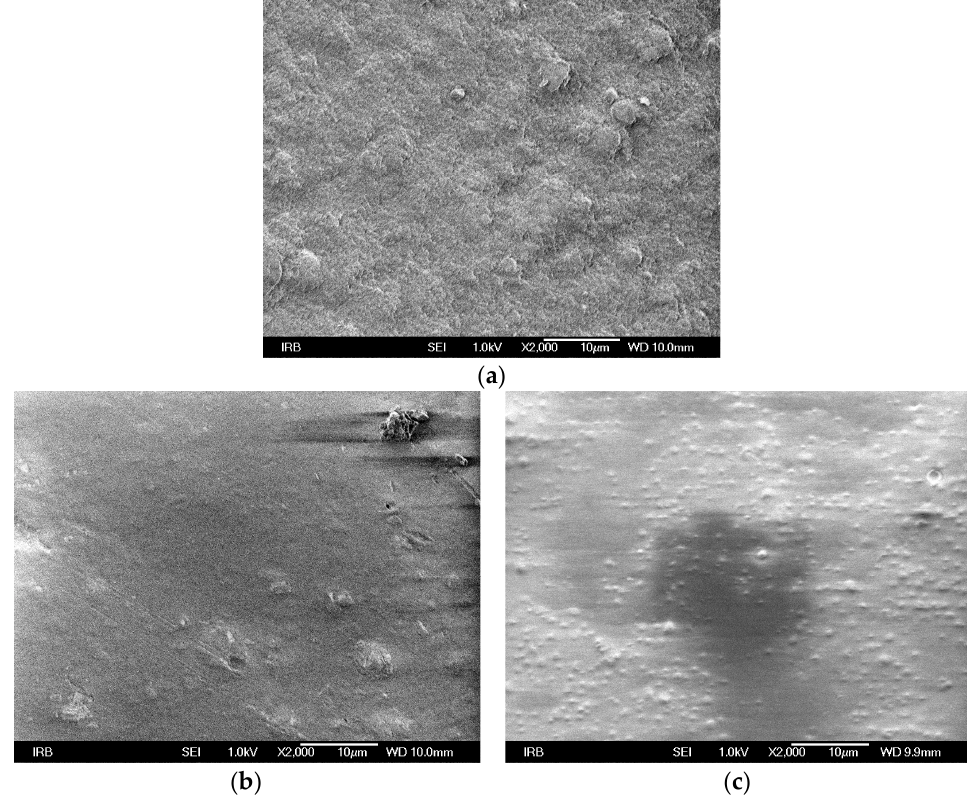
Figure 1. SEM micrographs of ( a ) unprinted substrate; ( b ) conventional ink; and ( c ) thermochromic ink.